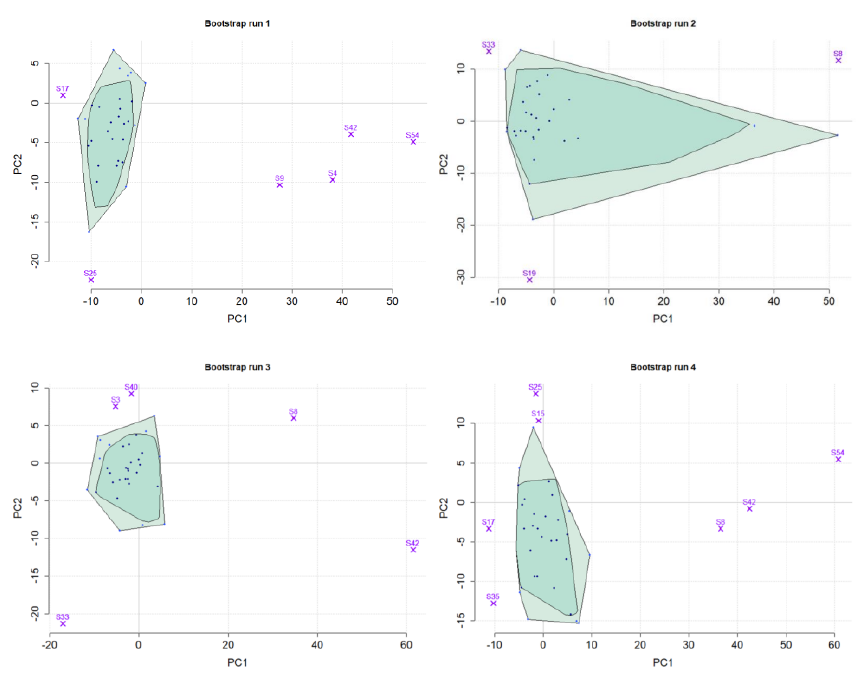
Figure 4. Four (out of 100) bootstrapped datasets from one simulation run in the PCA space with bagplots for outlier detection. The figure shows bootstrap samples always from the same study group. It can be seen in the selected example runs that not all outliers are detected in each bootstrap run. This may be because a simulated outlier was not selected for the respective bootstrap dataset or because the presence or absence of other samples in the bootstrap dataset prevents the outlier from being detected as such. In the same way, regular samples can be detected as outliers. The simulated outliers for study group 2 in this simulation run were ‘S4’, ‘S8’, ‘S9’, ‘S42’, and